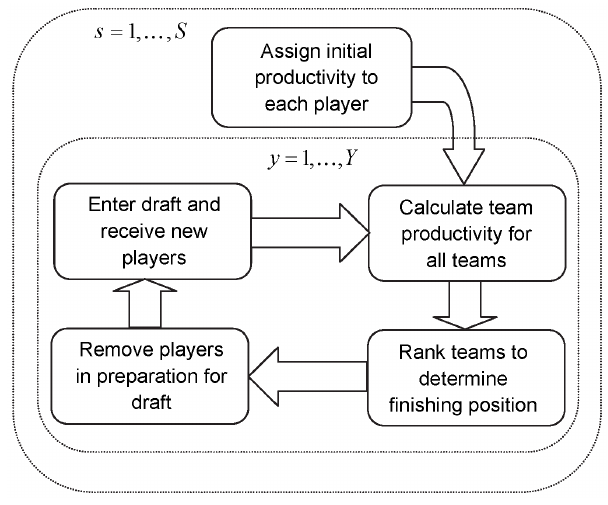
Figure 1. A diagrammatic representation of the major compo- nents of the player draft simulation model, iterated over a total of S simulations and Y years.